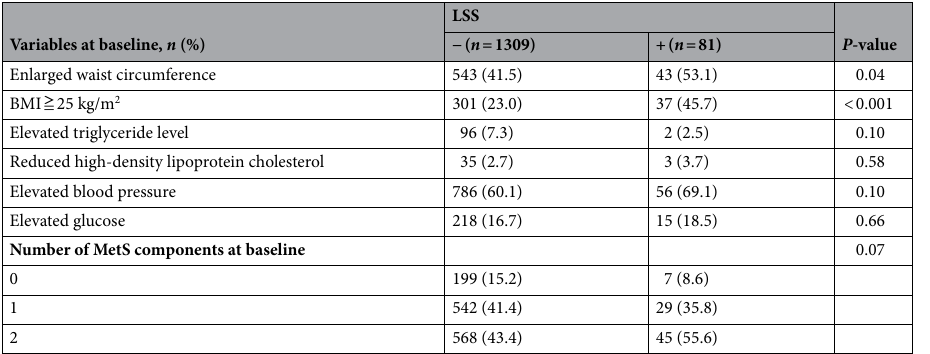
Variables at baseline, n